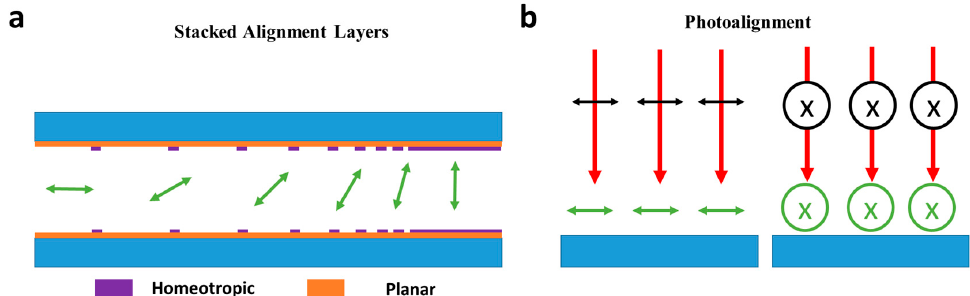
Figure 6. Schematic of variations in director orientations due to different alignments ( a ) Stacked alignment layers can smoothly vary pretilt angle through scribing through the top alignment layer to reveal the alignment layer underneath. Here, the density of scribing will increase planar alignment, allowing for the continuous variation of azimuthal angle. ( b ) Shows an example of photoalignment, where the radial orientation of the alignment can rotate when exposed to an optical field of a particular linear polarisation.